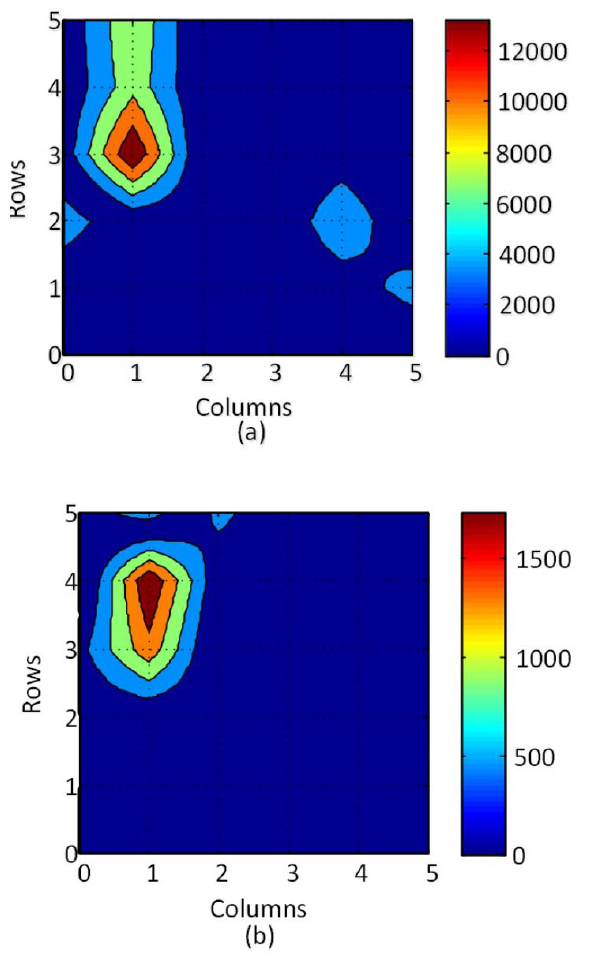
Fig. 13. Compaction stains mapping: (a) proposed method and (b)